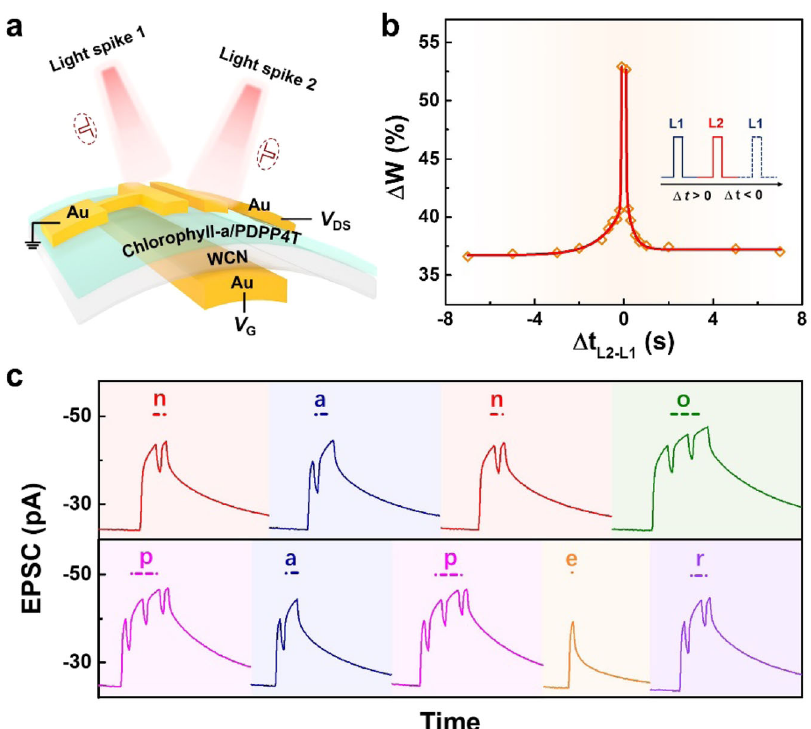
Fig. 4 Demonstrations of spatiotemporal summation and optical wireless communication. a Schematic of the simulating of spatiotemporal summation in the optoelectronic synaptic transistor by employing two optical spikes with the Δ t L2 – L1 (665 nm, 0.20 mW cm − 2 , 0.2 s). b Δ W as a function of Δ t L2 – L1 . c EPSCs evoked by a series of optical spikes (665 nm, 0.20 mW cm − 2 ) with the International Morse code of ‘ NANOPAPER ’ . The spike duration of dot and dash patterns are 0.5 and 1.5 s, respectively, and the interval between two optical spikes is fi xed at 0.5